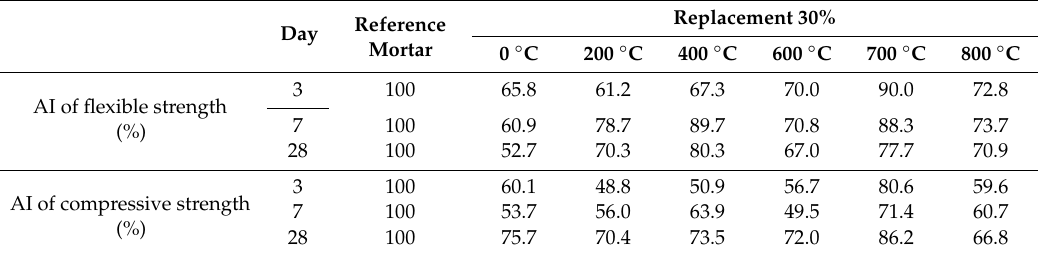
Table 5. AI values for heated WCP according to the mechanical